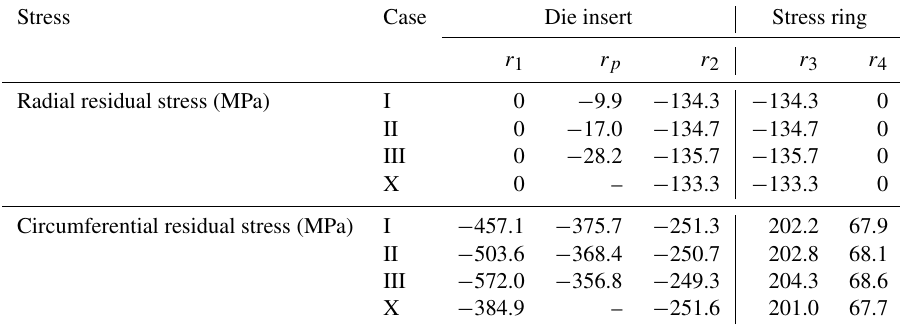
Table 4. Residual stresses in cases with different ratios of the plastic area.